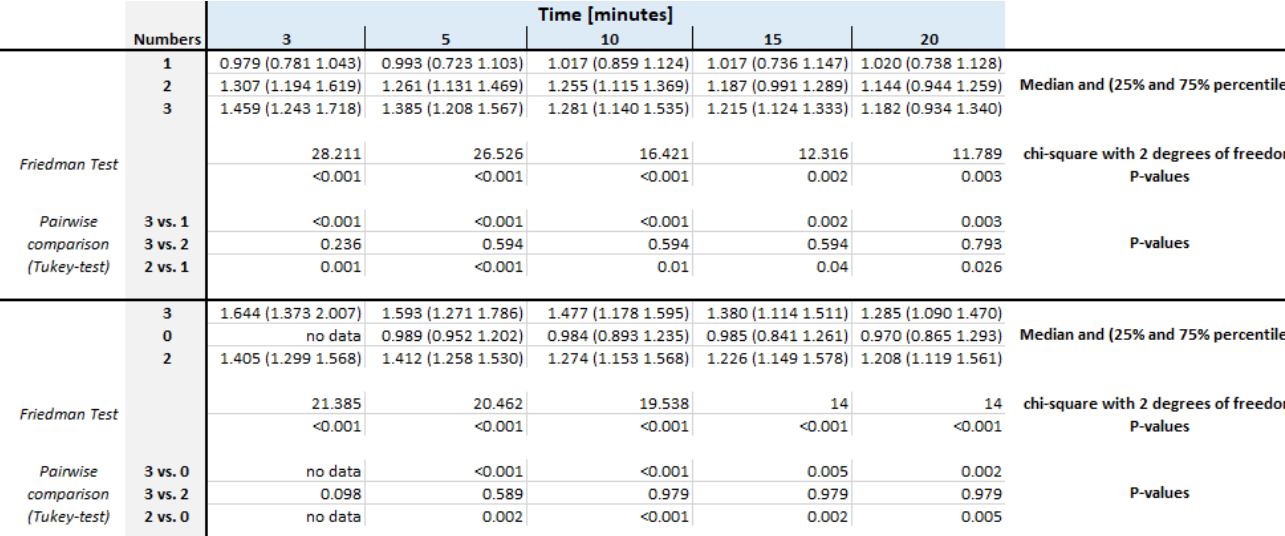
Table 2: Statistical evaluation of G ratio (t) at time points 3, 5, 10, 15 and 20 minutes over all recordings with number 123 (top, N=19) and number 302 (bottom, N=13). Median and 25% and 75% percentiles of G ratio (t) are presented, followed by the results from Friedman test and the results from the pairwise comparison (Tukey test). Within group comparisons of the measurements with number 123 show that there are significant differences (see P-values) between states 3 and 1 and also between states 2 and 1 but not within states 2 and 3 (P-values > 0.05). This is valid for all picked times. Within group comparisons of the measurements with number 302 show that there are significant differences between states 3 and 0 and also between states 2 and 0 but not within states 2 and 3, which is similar to the measurements with number 123.